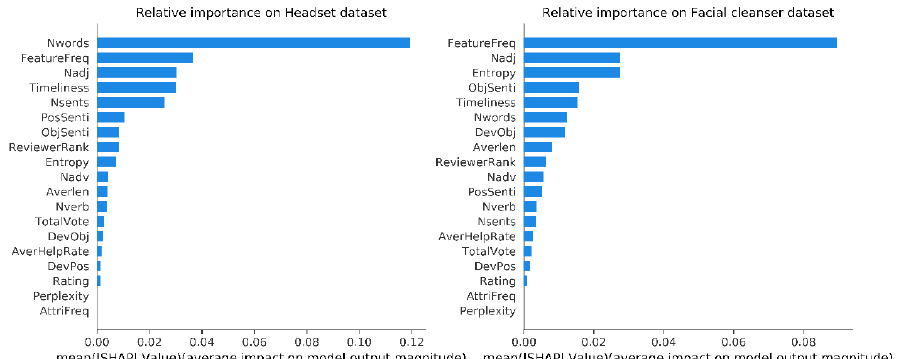
Figure 3. Global feature attribution across two datasets. (Source of data: https://www.amazon.cn).